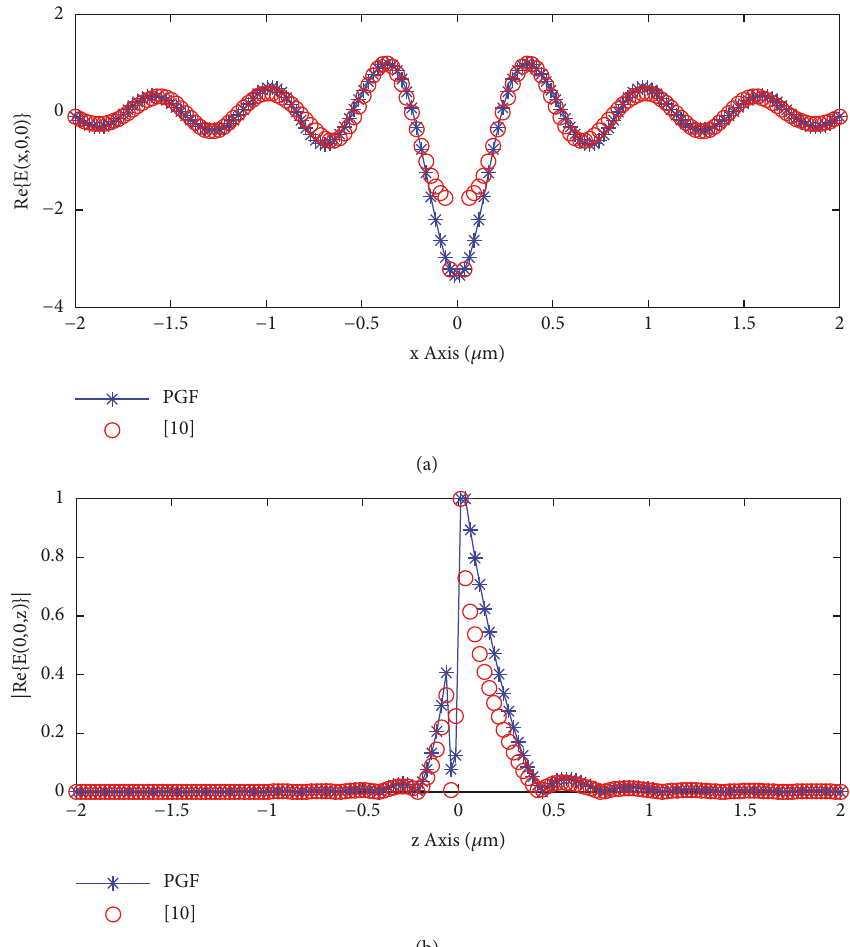
Figure 6: Results of the PGF and [10] for the component 𝐸 𝑧 : (a) Re {𝐸 𝑧 (𝑥,0, 0)} , (b) | Re {𝐸 𝑧 (0, 0, 𝑧)}| . In these results we set the following: 𝛿 = 50𝑛𝑚 , ℎ = 20𝑛𝑚 , 𝜃 󸀠 = 𝜙 󸀠 = 0 ∘ , and 𝜆 = 632.8𝑛𝑚 𝑔